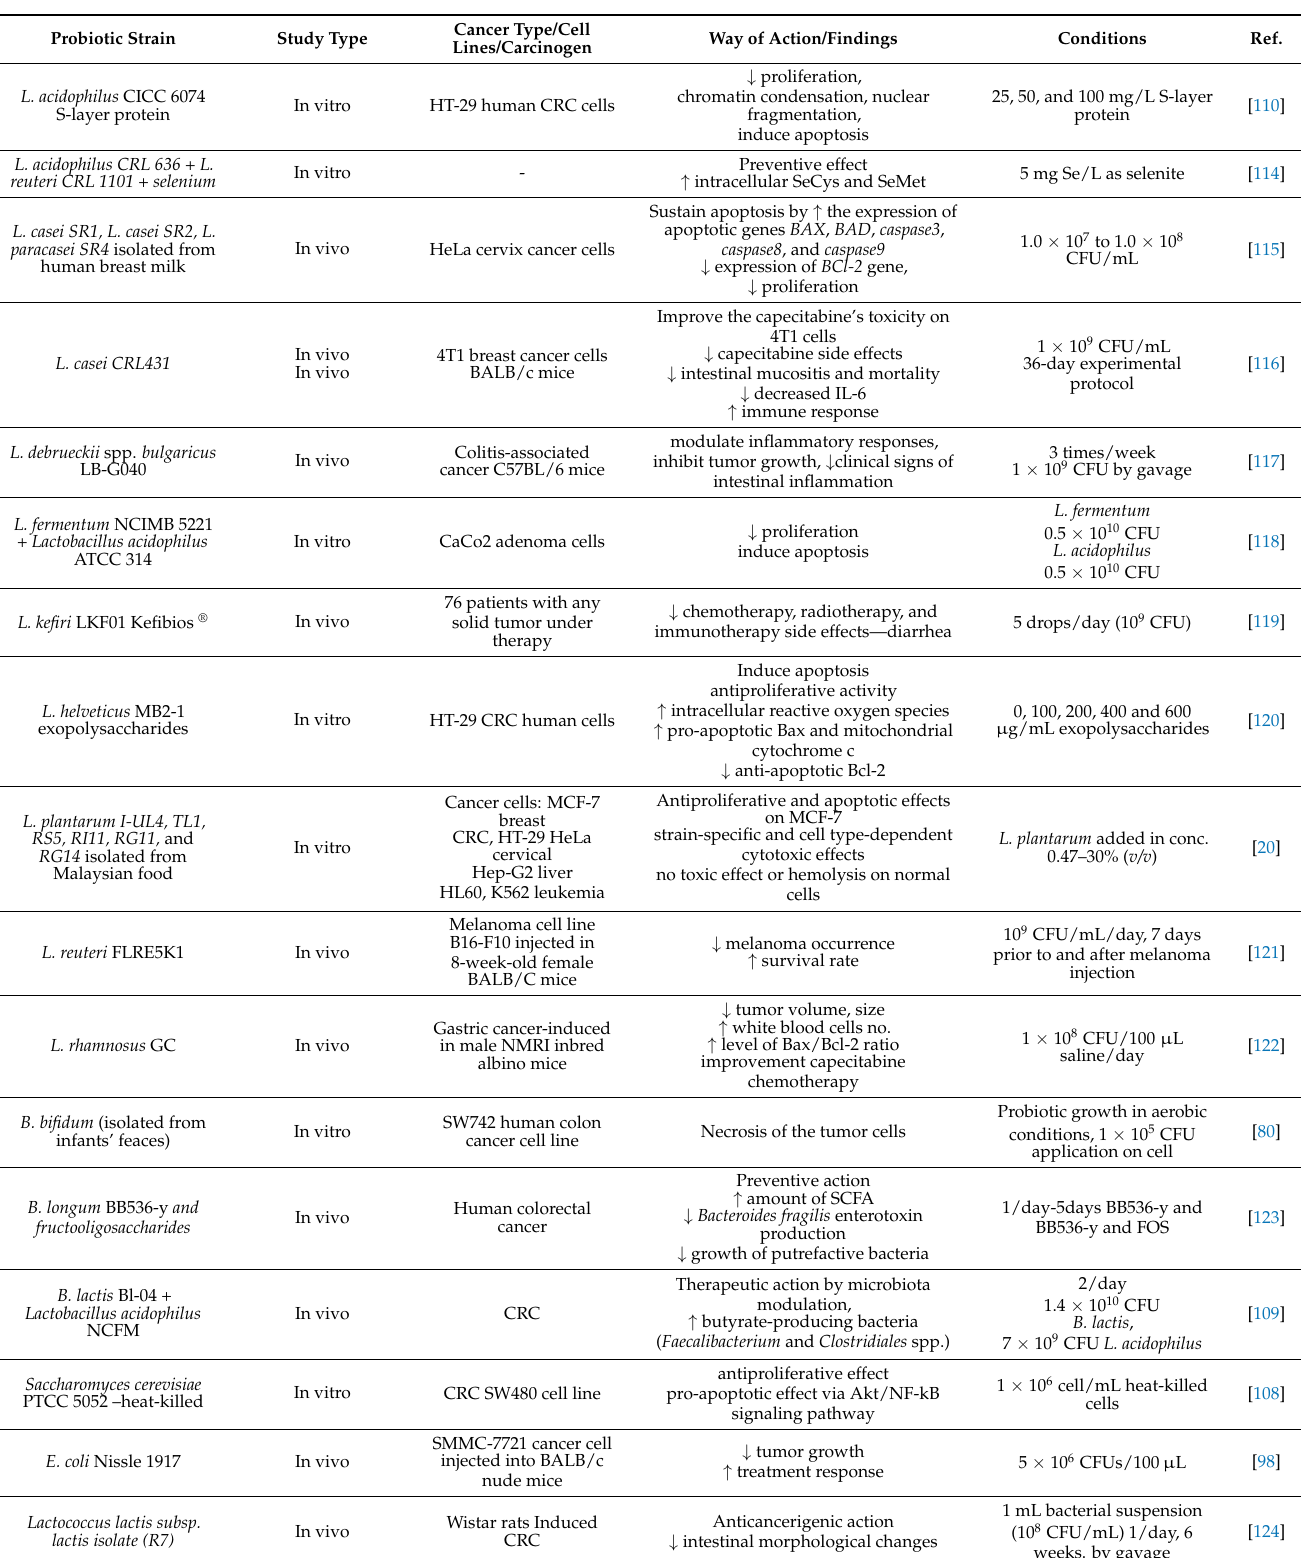
Table 5. Most used probiotic strains and their impact on different